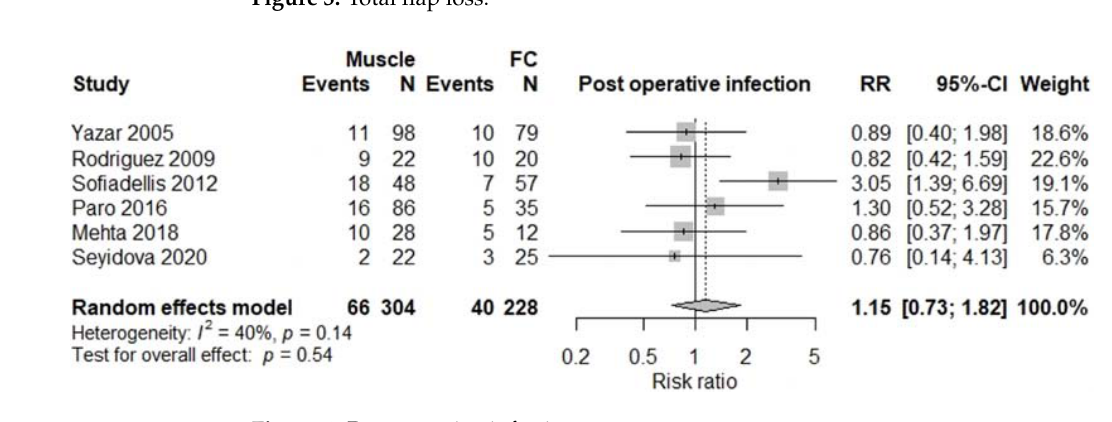
Figure 3. Total flap loss.